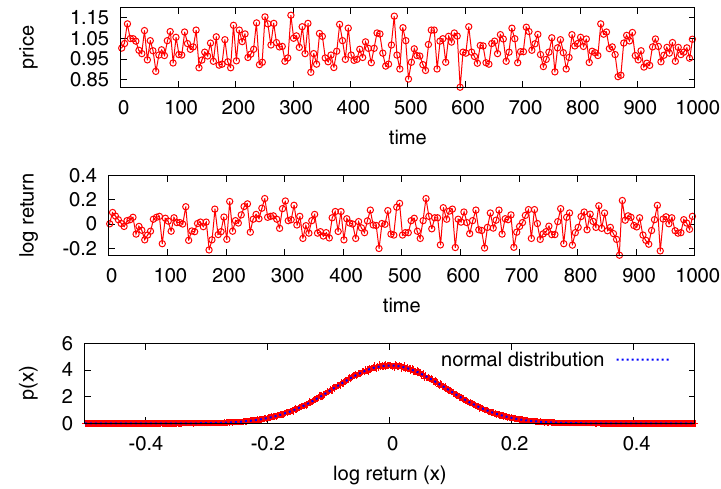
Fig. 8. The time series of prices, i.e., ratio of total stock and total money invested at a time is plotted for constant (cid:1) ¼ 0 : 9 . The following panels show the log-return and the size distribution of the log-returns which matches with a normal distribution.